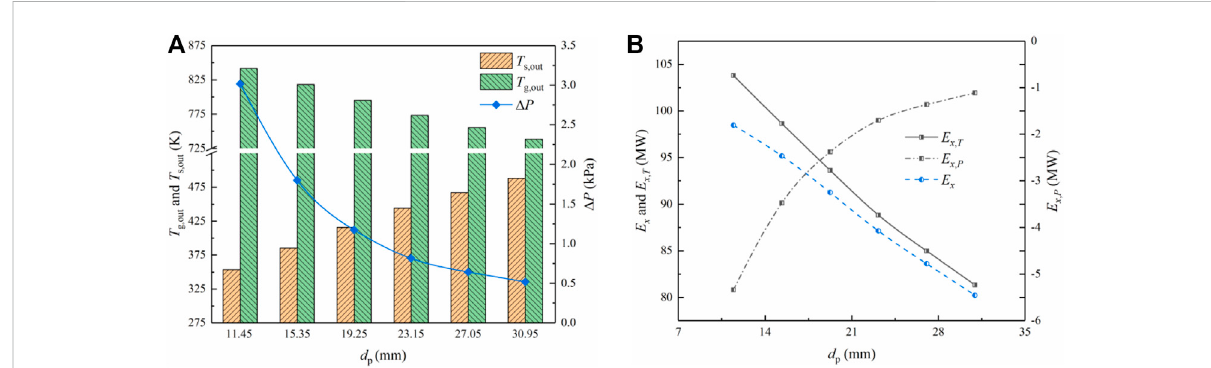
FIGURE 12 Thein fl uenceoftheequivalentparticlediameter d p ontheverticalcoolingprocess: (A) Changeofthesinteroutlettemperature T s , out ,gasoutlet temperature T g , out and pressure drop Δ P with d p ; (B) Change of the temperature exergy E x , T , pressure exergy E x , P and income exergy E x with d p .